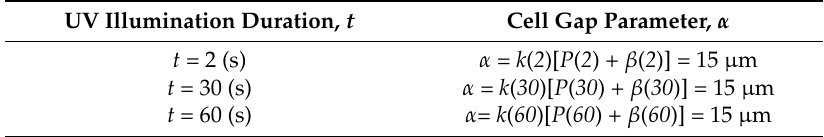
Table 1. Relationship of α , β ( t ), k ( t ), and P ( t ) as t = 2, 30, and 60 s and α = 15 µ m.